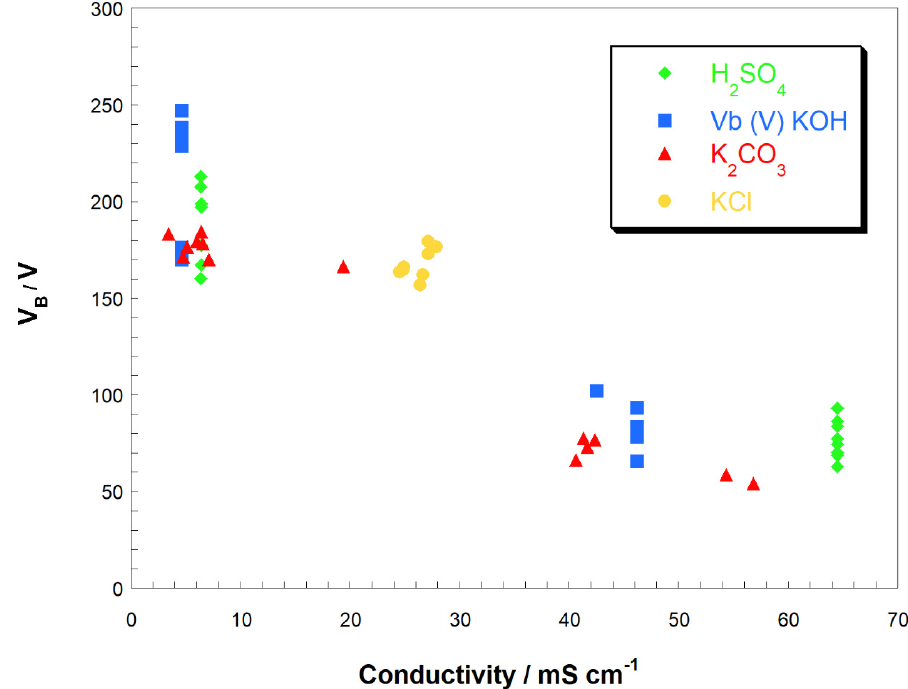
Figure 3. Breakdown voltage V B as function of electrolyte conductivity when different supporting electrolytes are used. In this series of experiments cathodic plasma is formed. Types of electrolytes: acid (i.e., H 2 SO 4 , diamonds), base (KOH, squares), salt with a weak base as anion (K 2 CO 3 , triangles) and salt (KCl, circles).